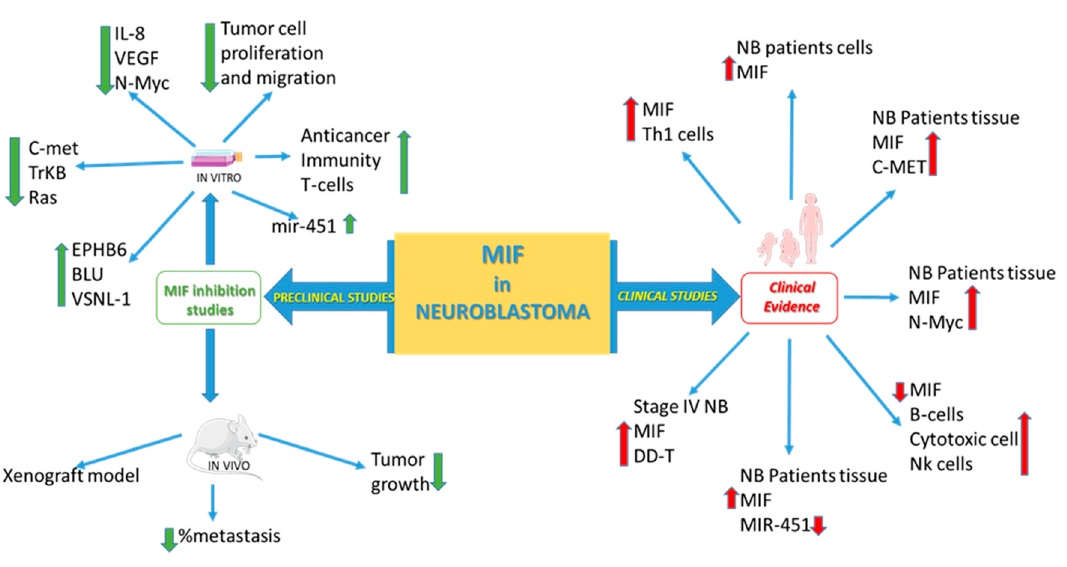
Figure 2. MIF in neuroblastoma (NB).